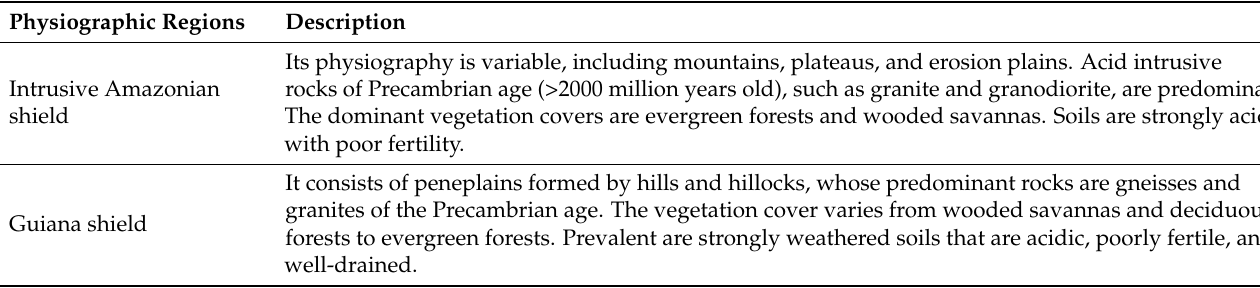
Table A3. Physiographic regions south of the Orinoco River according to Elizalde et al.